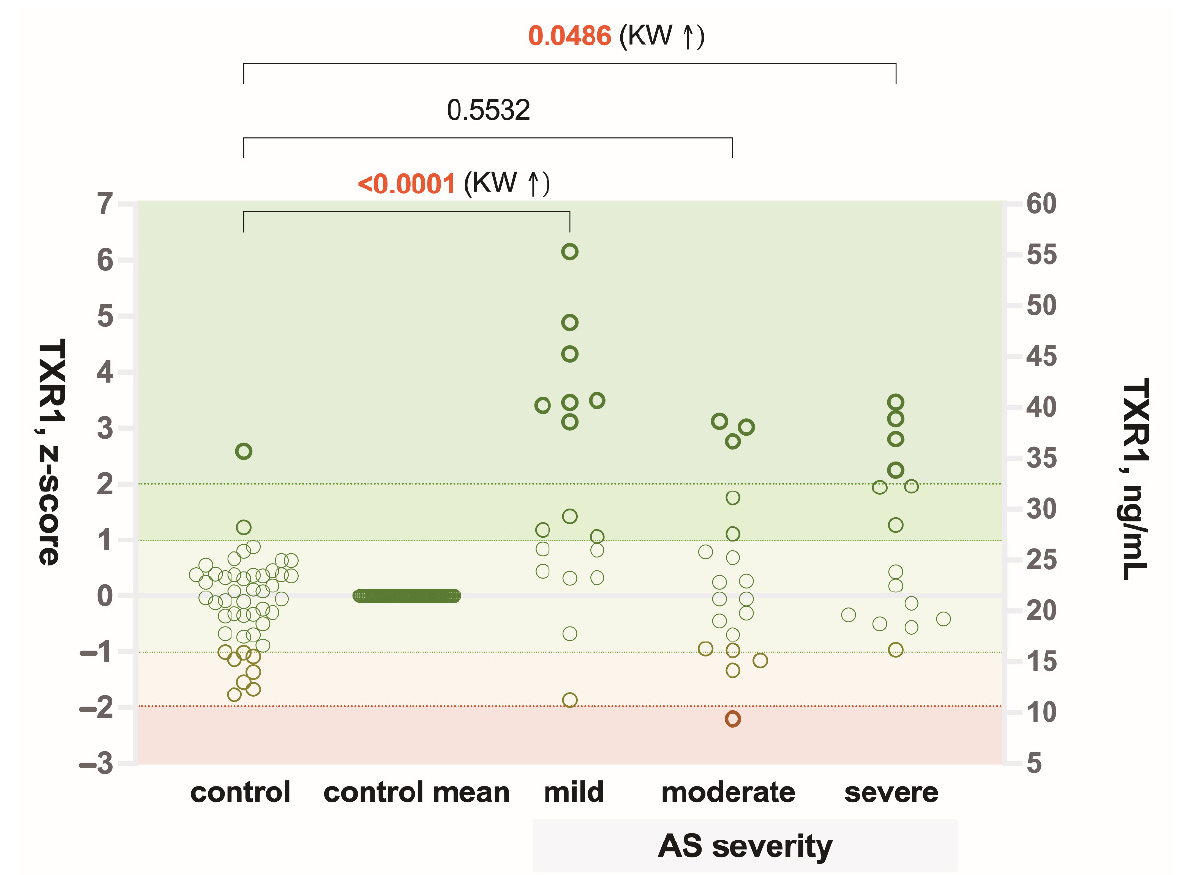
Figure 4. Comparison of plasma thioredoxin-1 (TRX1) concentration in mild, moderate and severe aortic valve stenosis (AS) patients to control subjects. KW—Kruskal–Wallis test; z-score—distance of data point from the control mean, expressed in standard deviations.